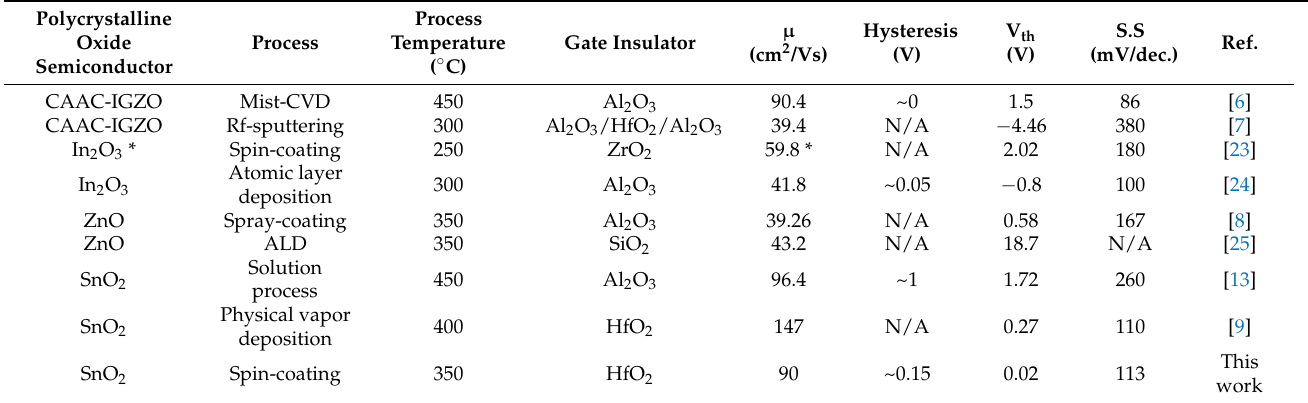
Table 1. A comparison of various TFT performances using polycrystalline oxide semiconductors and their processing